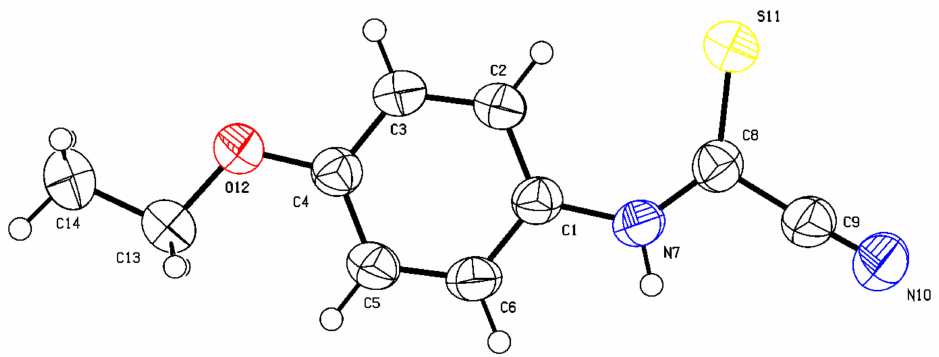
Figure 3. The crystal structure of (4-ethoxyphenyl)carbamothioyl cyanide ( 27p ) (Deposition Number 2179720 ). For bond distances (Å) and angles (deg), see Supplementary Materials